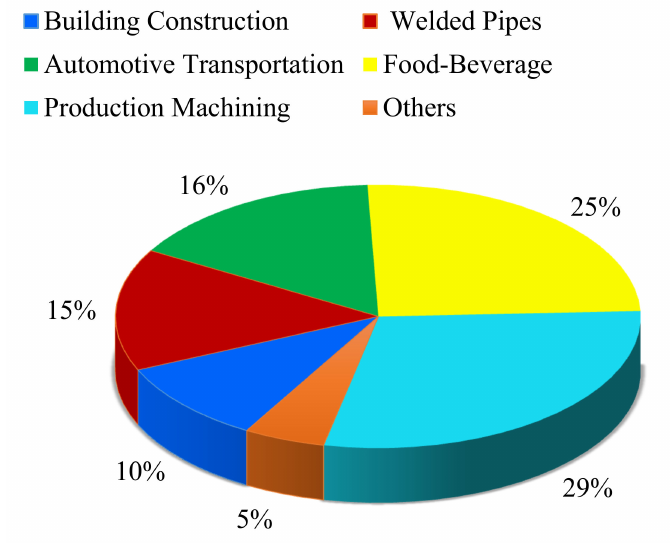
Figure 8. Division of steel usage in different applications.